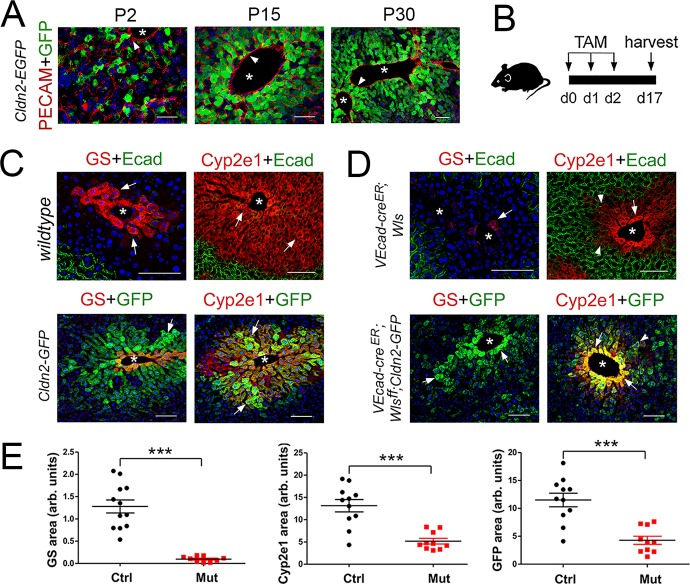
Wls deletion in HECs severely reduces the expression of claudin-2 and Cyp2e1 in perivenous hepatocytes in adult livers.(A) Immunofluorescence results showing that pericentral claudin-2/GFP+ hepatocytes physically contact the central vein endothelium (PECAM+, arrowheads) in newborn (P2) juvenile (P15) and adult (P30) Cldn2-EGFP livers. (B) Schematic of tamoxifen administration and tissue harvesting. (C) Tamoxifen injection does not affect the zonated distribution of GS, Cyp2e1 and E-cadherin in wildtype livers (top, arrows), or claudin-2/GFP, GS and Cyp2e1 (bottom, arrows) in Cldn2-GFP livers. (D) Wls deletion in endothelial cells causes near depletion of GS+ hepatocytes (top left, arrows), decreases both Cyp2e1 (right panels, arrows) and claudin-2/GFP perivenous expression (bottom panels, arrows; arrowheads show distal perivenous hepatocytes expressing low GFP), and expands E-cadherin expression into the margins of Zone 2 (top right, arrowheads). (E) Quantification of Zone 3 (GS+) and Zone 2 (Cyp2e1+/GFP+) areas in adult livers with or without endothelial Wls. Statistical difference was determined by two-tailed unpaired Student’s t-test (***p<0.001, 3–4 representative fields from three individual livers of each genotype were used for quantification). Each image represents three individual livers. Asterisks indicate central vein lumens. Scale bars: 50 μm (A), 100 μm (C,D). Related data can be found in Figure 2—figure supplement 1.Figure 2—source data 1.Quantification of Zone three and Zone two areas in adult livers with or without endothelial Wls.